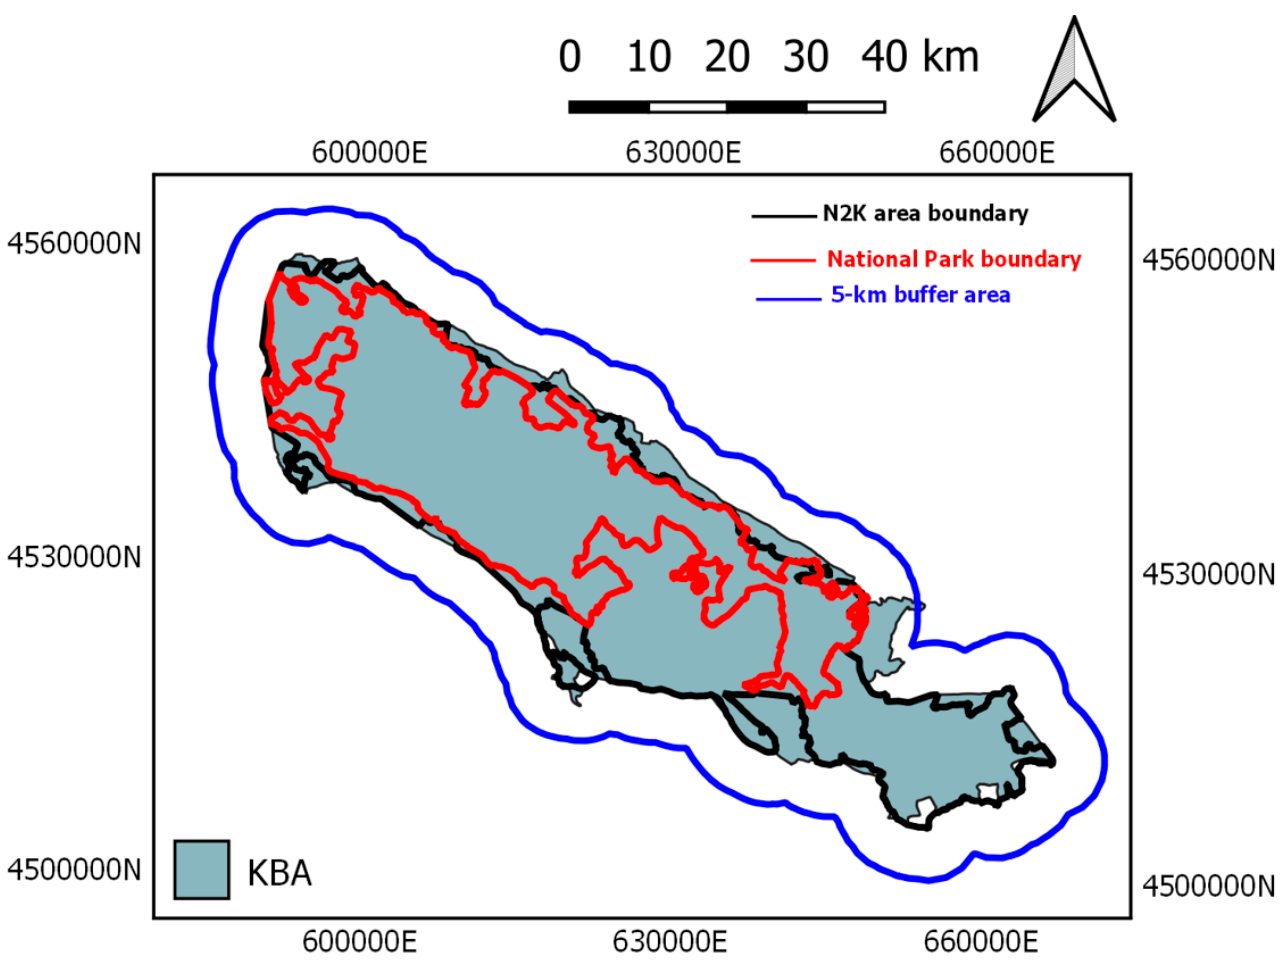
Figure 4. In grey colour, KBA area corresponding to the study